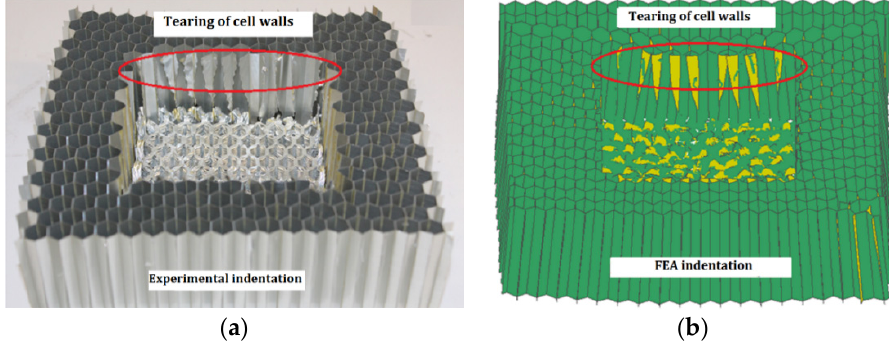
Figure 3. Comparison between experimental [7] and FEA deformation pattern of honeycomb H42 under indentation: ( a ) experimental post ‐ test specimen; ( b ) FEA post ‐ test specimen.